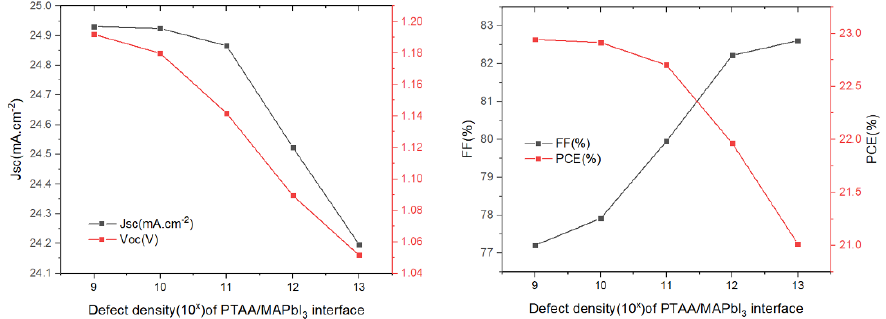
Figure 8. Influence of the HTL/absorber interface defect density on the photovoltaic parameters ( V oc , J sc , FF , and PCE ).